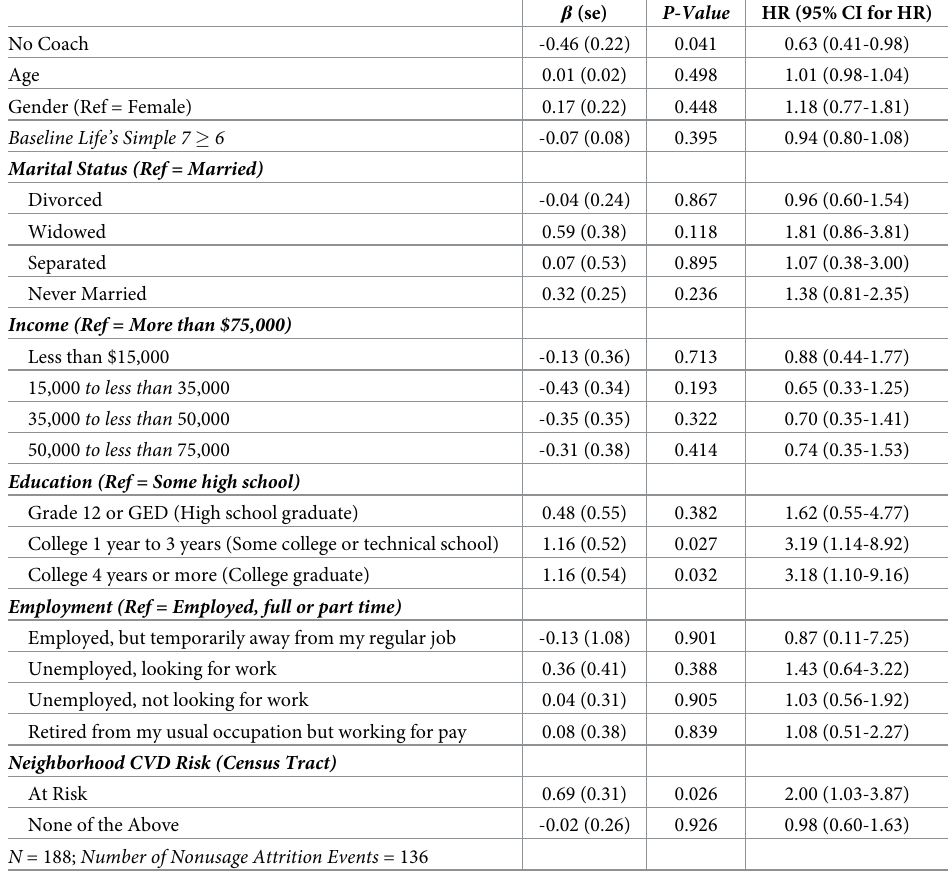
Table 2. Estimates of the Cox proportional hazard model of nonusage